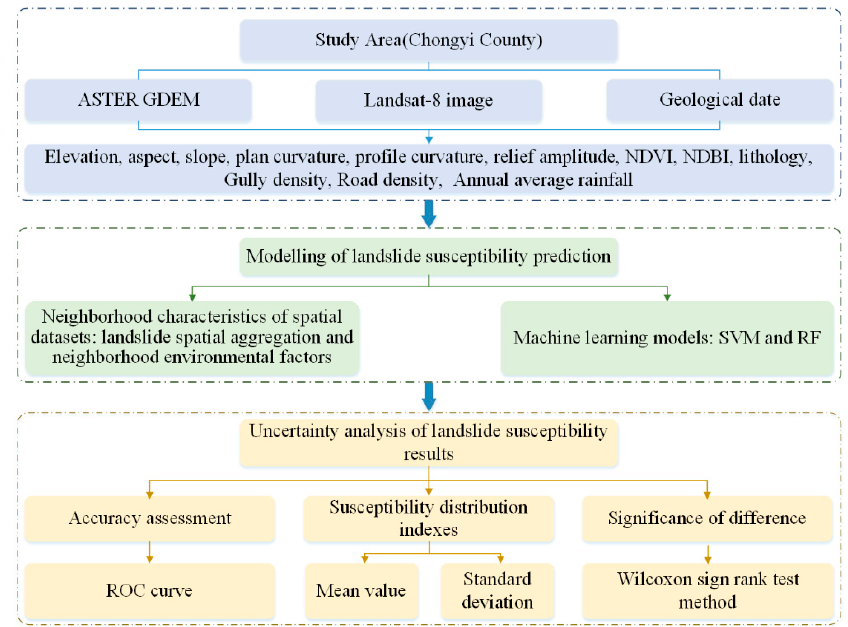
Figure 1. The process of LSP modelling.